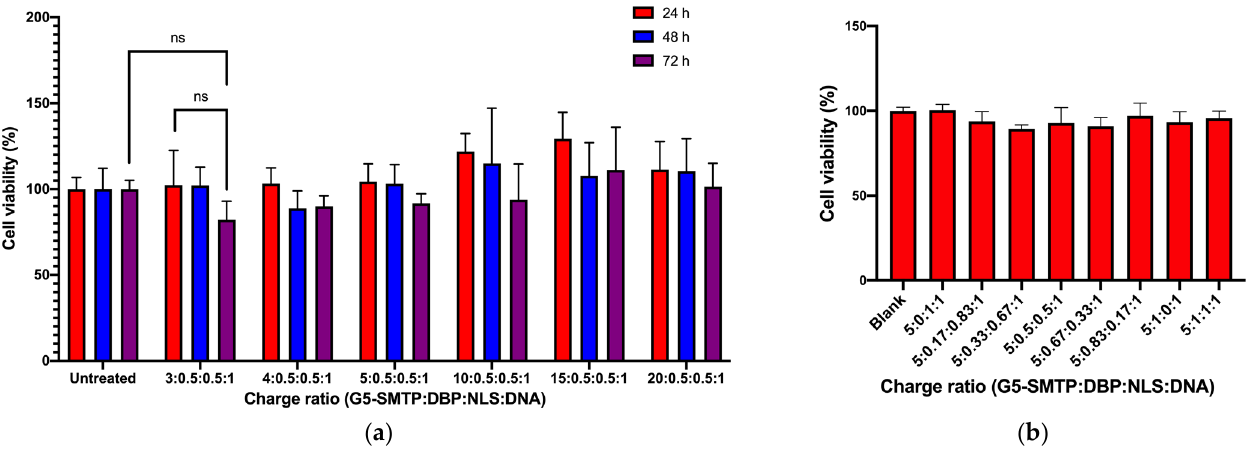
Figure 4. Cytotoxicity analysis of the polyplexes from the MTS proliferation assay using C2C12 cells. ( a ) Variations in cytotoxicity with different amounts of the dendrimer. Cell viability was monitored over 3 days. ( b ) Variations in cytotoxicity due to changes in the ratio of the DBP and NLS peptides while keeping the amount of the dendrimer the same.